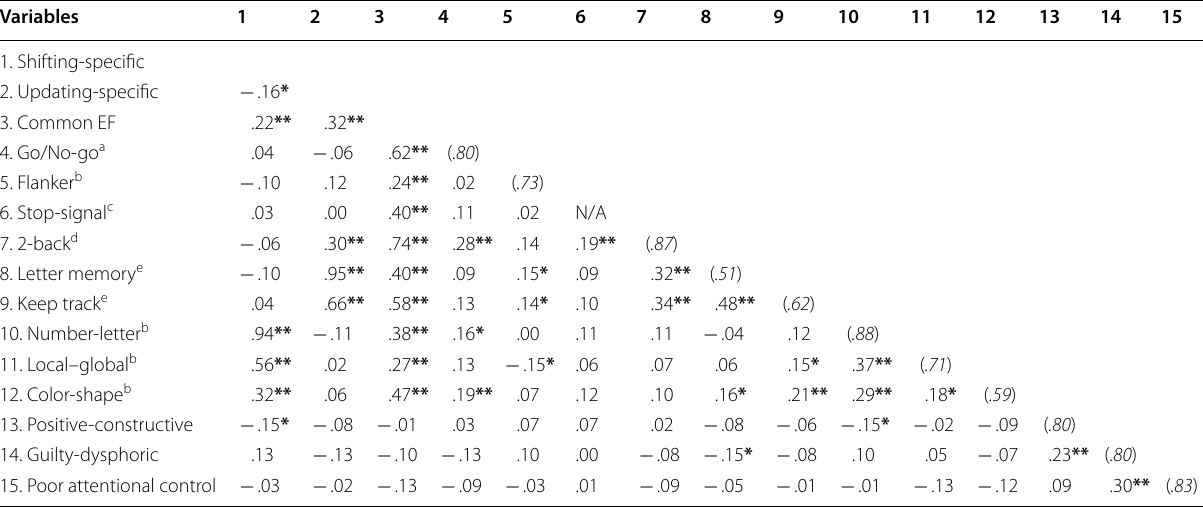
N 193. Higher scores reflect better performance on all tasks = a